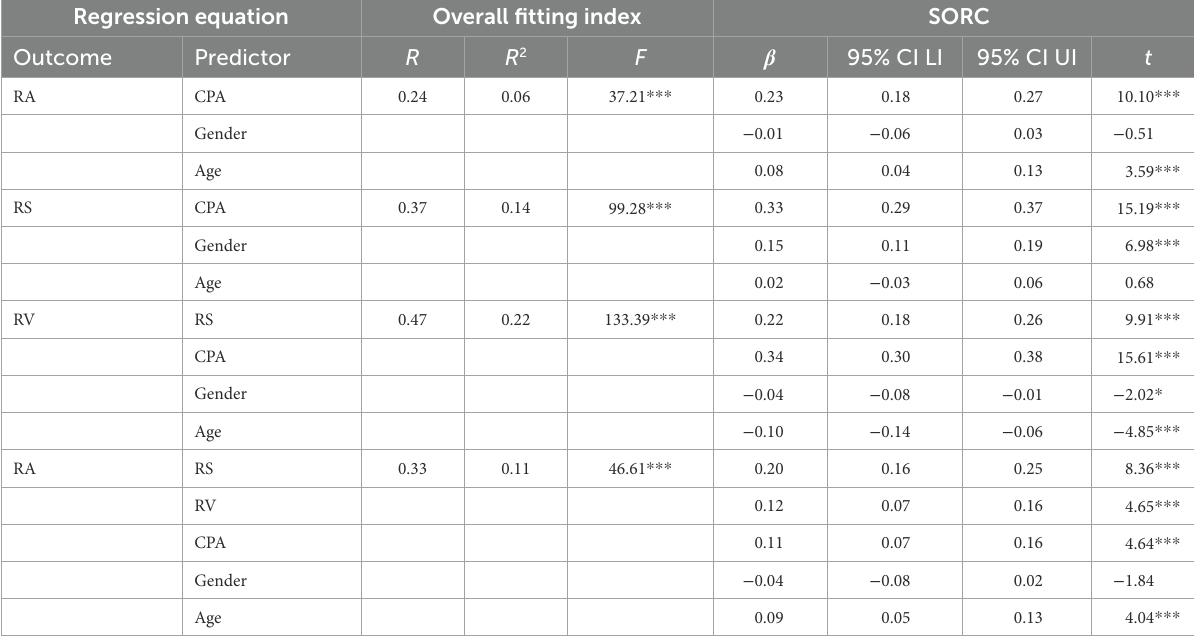
TABLE 3 Regression analysis of variables in the model. Regression equation